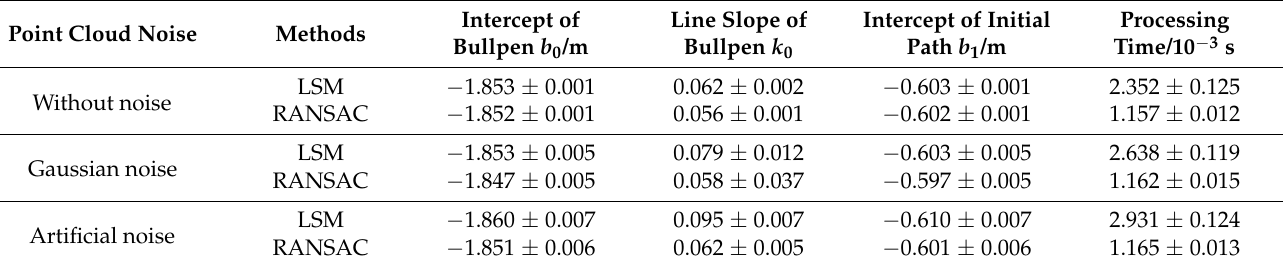
Table 3. Extraction of bullpen line and initial path analysis by LSM and